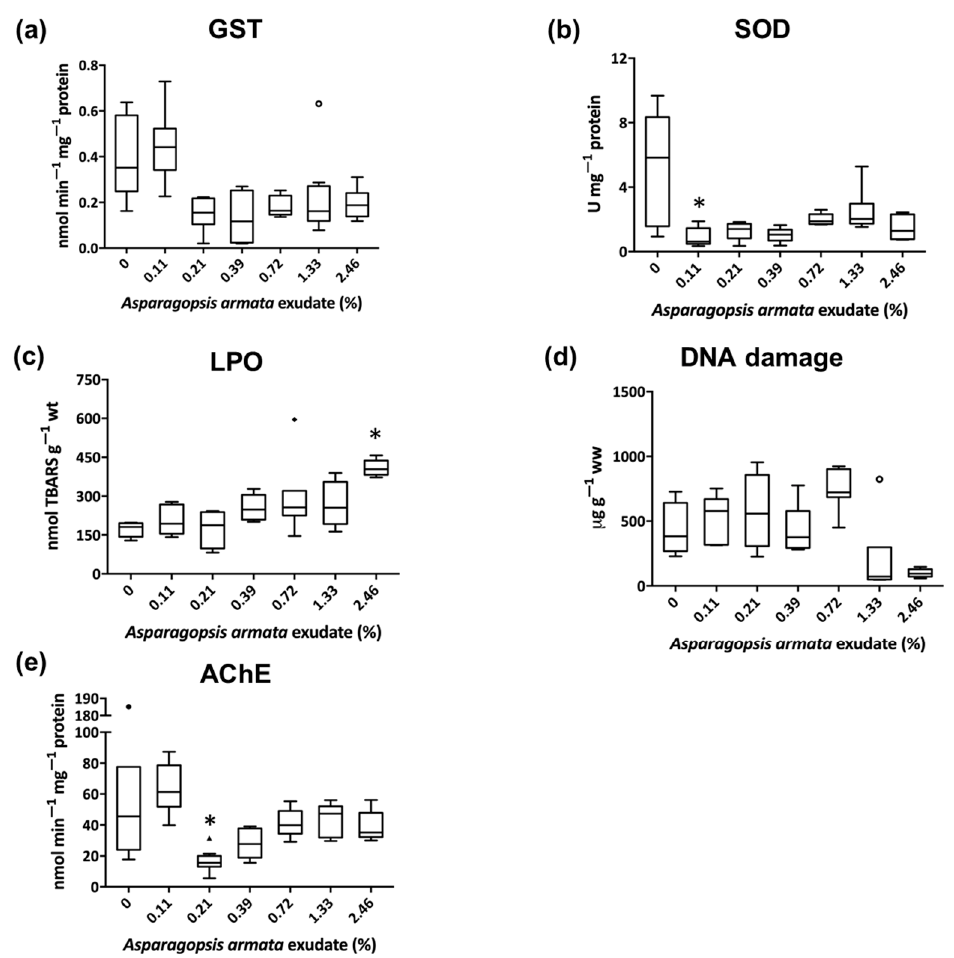
Figure 2. Results of detoxification and antioxidant defenses ( a , b ), oxidative damage ( c , d ), in Palaemon elegans ’ hepatopancreas tissue and acetylcholinesterase ( e ) in the eyes, when exposed to Aparagopsis armata exudate for 168 h ( n = 8). Results are shown in boxplot (i.e., the median, the first and the third quartiles, and the nonoutliers’ range and the outliers); * Significant differences from the control (Kruskal–Wallis, Nemenyi, p < 0.05).